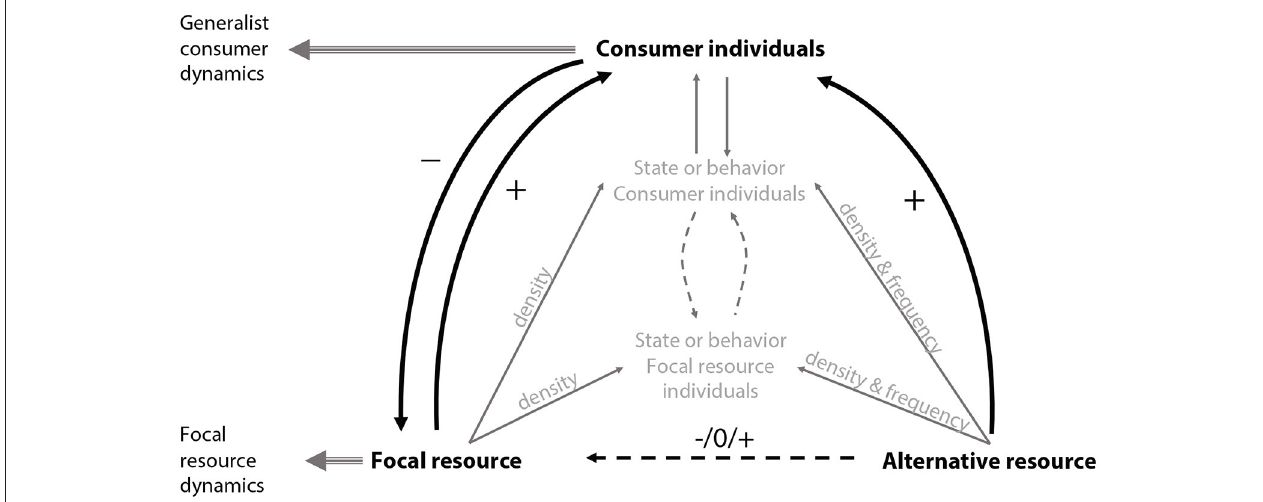
FIGURE 1 | Conceptual figure of the theory of apparent competition (Holt, 1977) and associational effects (Underwood et al., 2014). The black arrows indicate the indirect apparent interactions (+/0/– symbols indicate the direction of direct or indirect effects) and the gray arrows indicate the associational effects of resource neighborhood on indirect interactions between the resources and the effects on the consumers and feedback between the separate factors in the system. The figure does not include feedbacks from the focal resource and the consumer on the alternative resource, as in the case of a generalist consumer, as the alternative resource can be represented by multiple